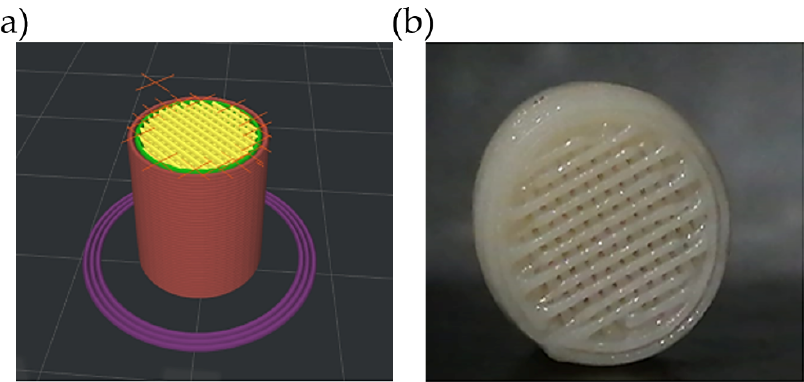
Figure 2. Microchannel visualization in ( a ) computerized 3D design and ( b ) PCL printed scaffold obtained via FDM.